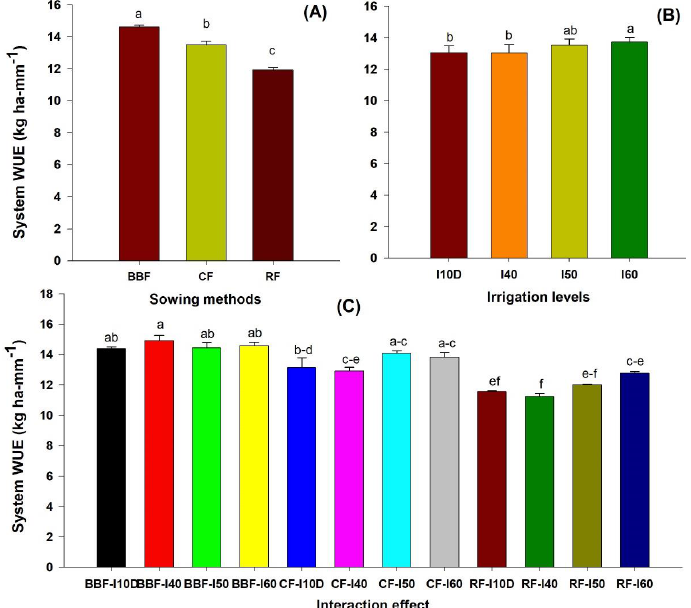
Figure 2. Water-use efficiency (WUE) of maize–cowpea system in response to sowing methods ( A ), irrigation levels ( B ) and interaction effect ( C ). BBF, Broad bed and furrow; CF, Corrugated furrow (shallow); RF, Ridges and furrow; I 1OD , Irrigation once in 10 days; I 40 , Irrigation at 40% depletion; I 50 , Irrigation at 50% depletion; and I 60 , Irrigation at 60% deple- tion. Means followed by the same letter (s) are not significantly differed by DMRT ( p =